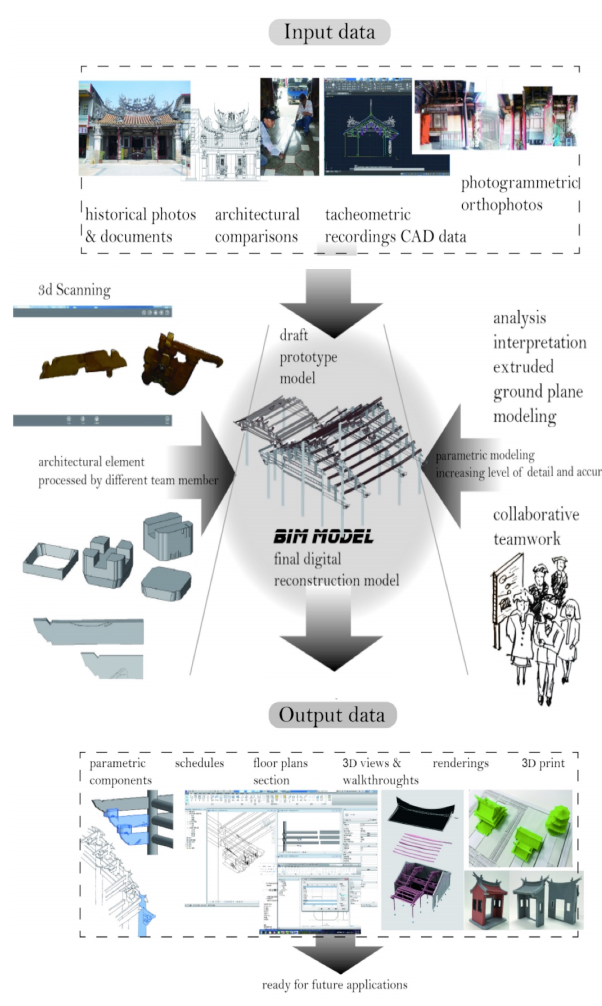
Figure 12. Parametric workflow for the Huji